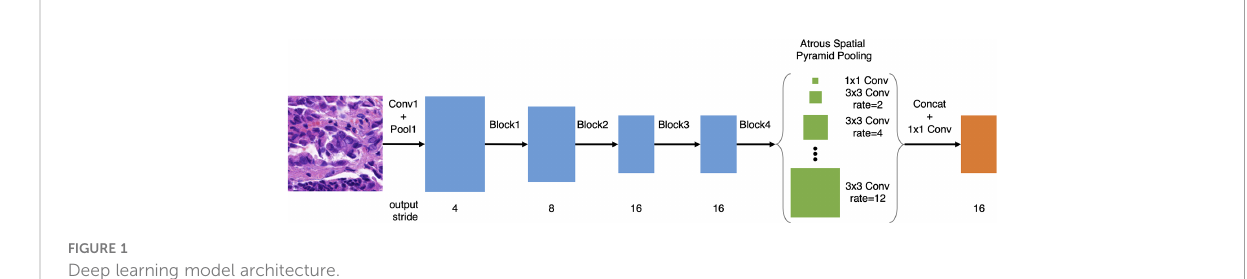
FIGURE 1 Deep learning model